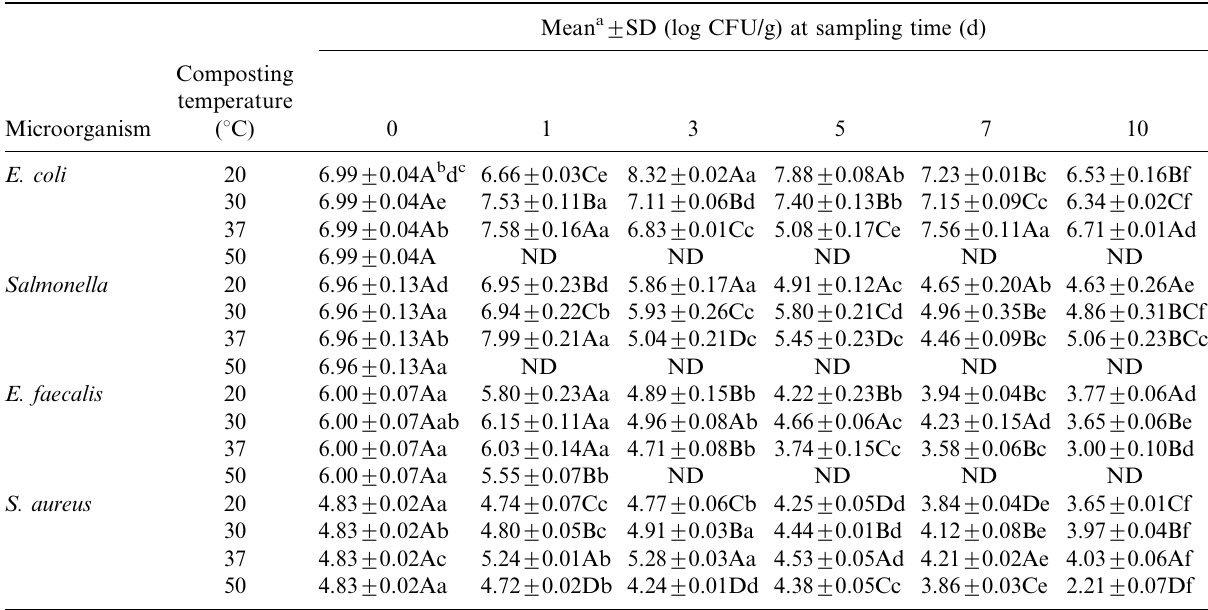
ND, not detected after enrichment. a The mean is the average of six replicates. b For each pathogen, means with different upper case letters in a column are significantly different (P B 0.05). c Means with different lower case letters in a row are significantly different (P B